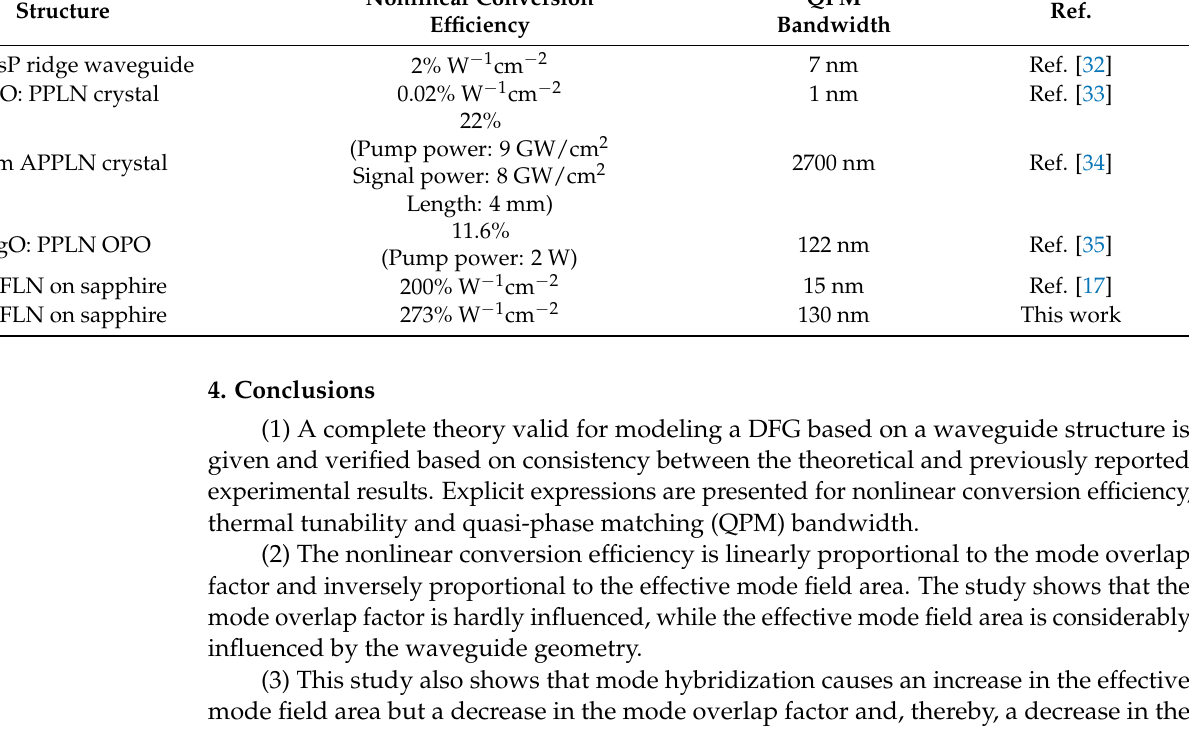
Table 1. Research on 3–4 µ m mid-IR nonlinear devices.